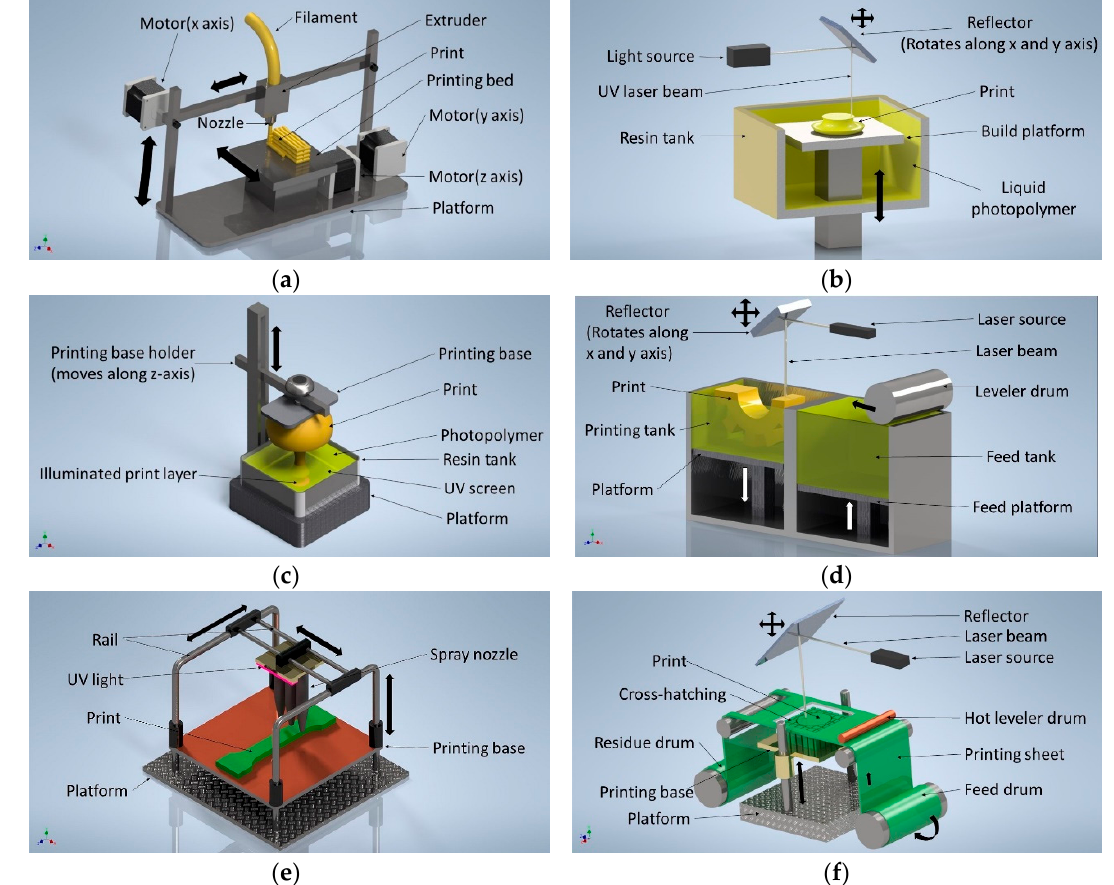
Figure 1. Selected techniques for polymer AM. ( a ) The Fused Deposition Modeling (FDM) printers work on the materials extrusion principle to print desired parts. ( b ) The stereolithography (SLA) technique uses a UV laser beam to cure liquid UV curable polymer for printing with high accuracy. ( c ) The digital light processing (DLP) printers print highly accurate parts using UV screens and are less time consuming than the SLA. ( d ) The selective laser sintering (SLS) fuses fine powder polymers with a laser beam. However, the printed parts produce rough or grainy surfaces. ( e ) In the polyjet printing process, fine drops of polymers are sprayed by multiple nozzles on the printing bed which are immediately cured by the UV light. It is capable of fast printing with multi-material deposition. ( f ) In the sheet lamination (LOM), sheets of polymers are precisely cut and added in layers to make the final product. When fast printing and large size printing capability are required, the LOM technique is preferred.